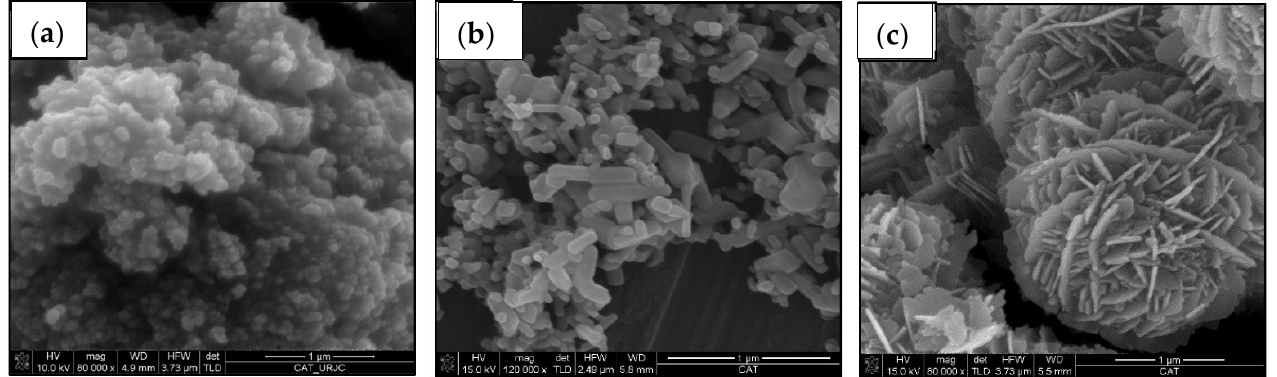
Figure 1. FEG-SEM micrographs of ceramic particles: ( a ) commercial TiO 2 , ( b ) commercial ZnO and ( c ) recycled ZnO.